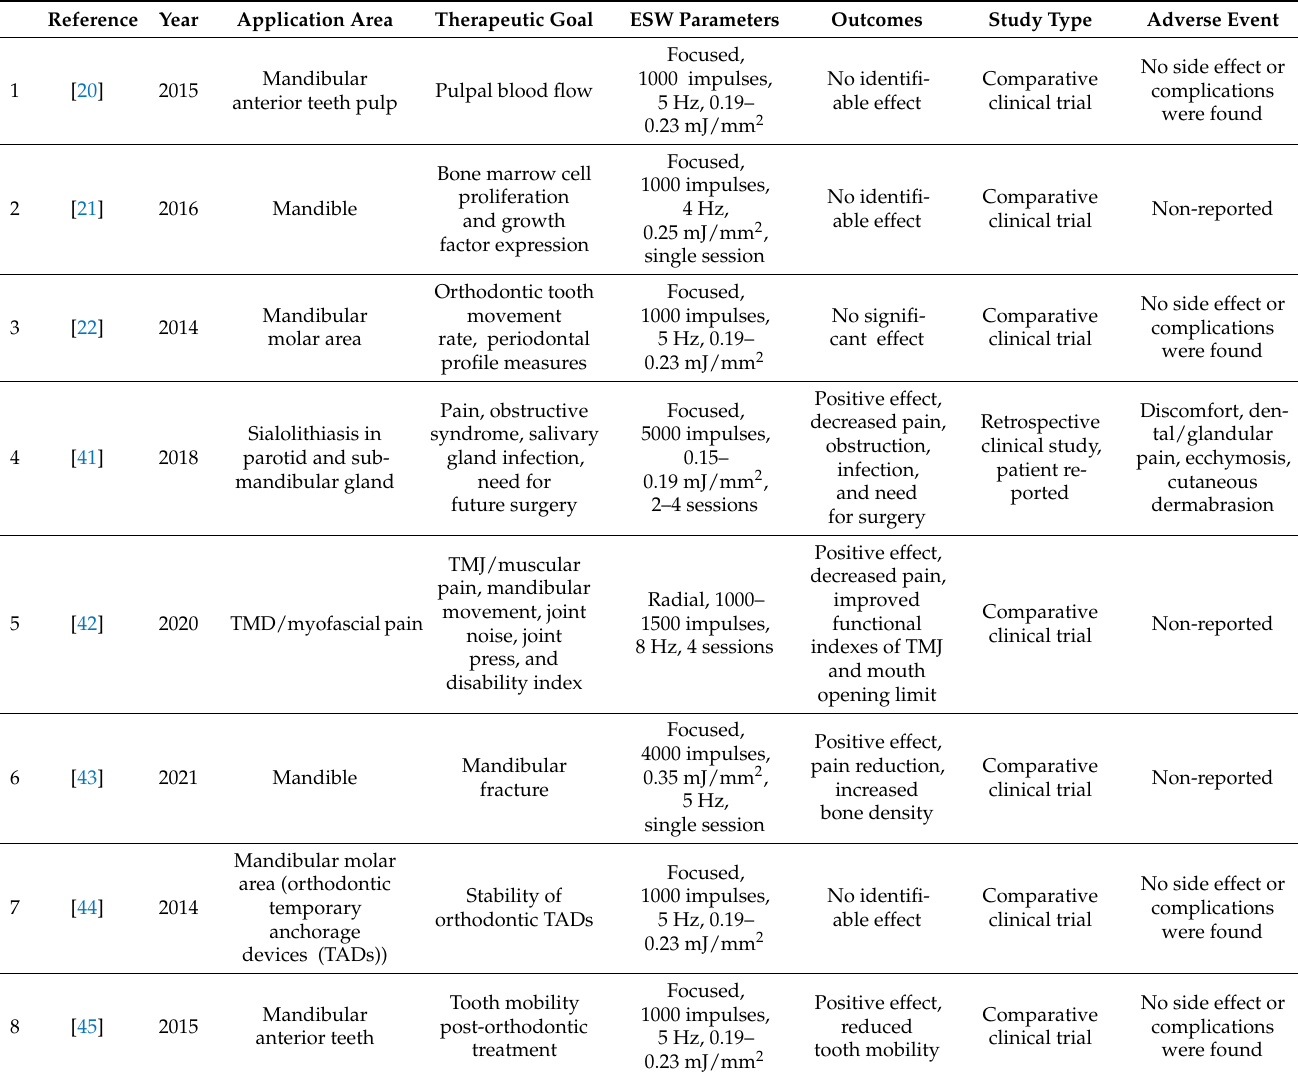
Table 1. Extracorporeal shock wave therapy (ESWT) applications in clinical studies in the oral and maxillofacial